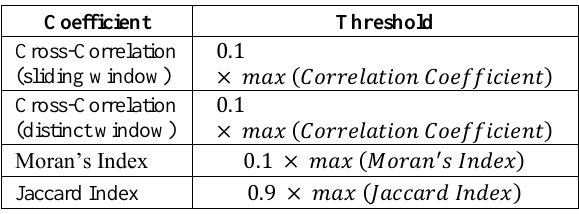
Table 1. Threshold selection criteria using spatial correlation